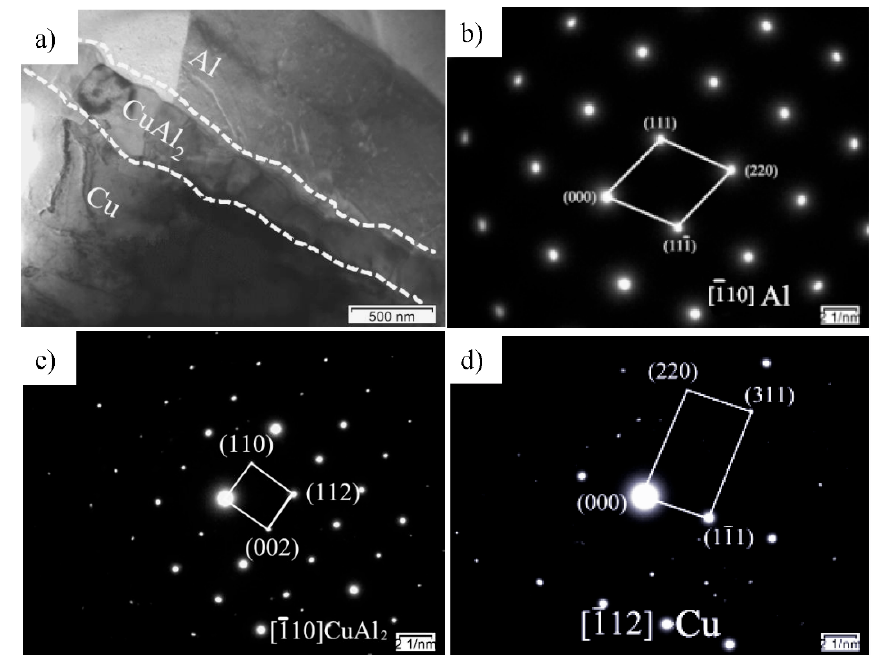
Figure 8. TEM image and electron diffraction patterns of the interface in Cu/Al composite panels: ( a ) TEM image; ( b – d ) electron diffraction patterns.